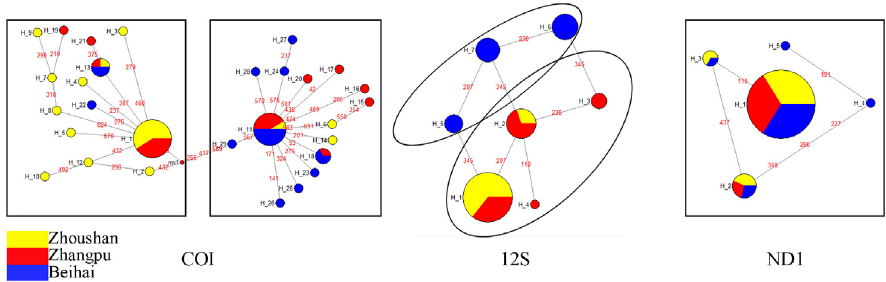
Fig 2. Median-joining network for COI, 12S rRNA, and NDI haplotypes of M . multifarius . On the connecting lines, red numbers present the variable sites between each haplotype pair. Different colors represent the 3 populations in the network.